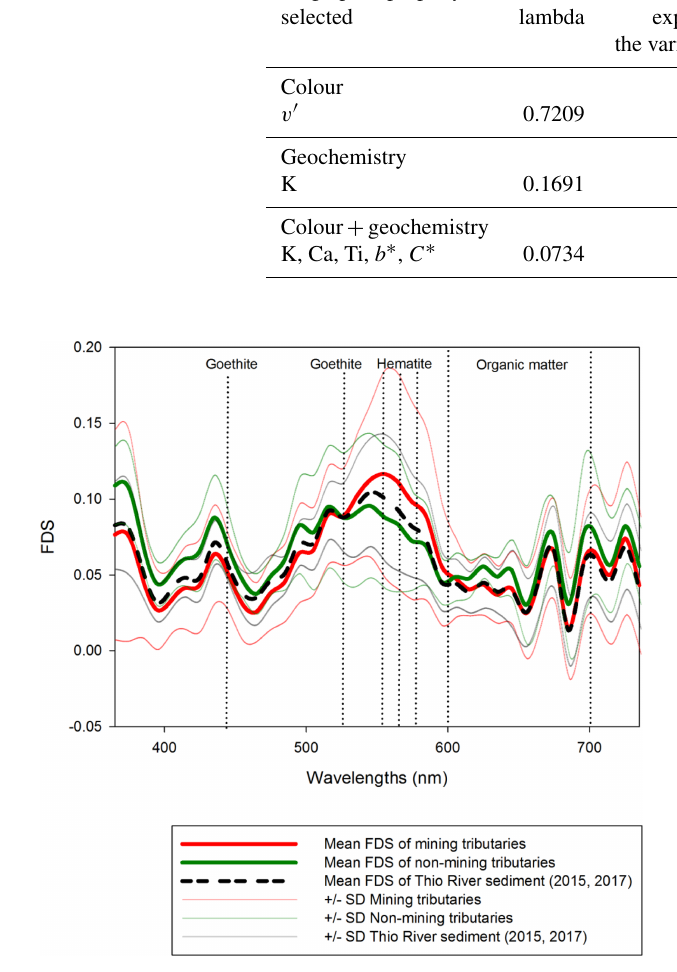
Figure 6. FDVS measured in the < 63µm fraction of sources and Thio River sediment